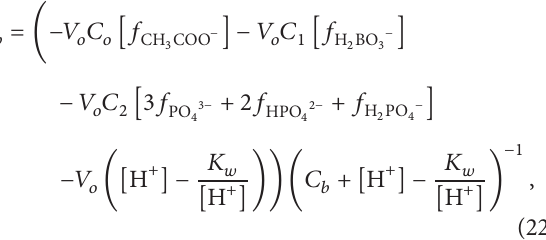
= ℎ(𝑉 ) (markers) and estimated with 𝑏 corr /𝑑𝑉 = ℎ 󸀠 (𝑉 ) ≈ Δ𝜅 /Δ𝑉 𝑏 𝑏 𝑏 (segmented corr corr